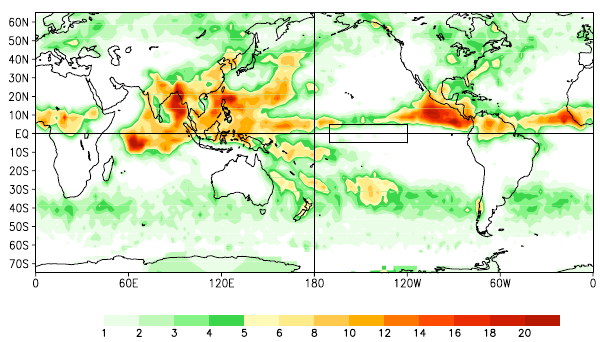
Fig. 17. The global July mean CMAP precipitation rate (mm/day) averaged between 1979 and 2005 (Xie and Arkin,